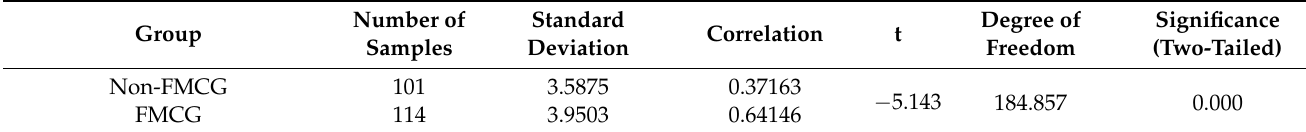
Table 11. The impact of different promotional product types in quantity-limited promotions on upward anticipated regret. Group